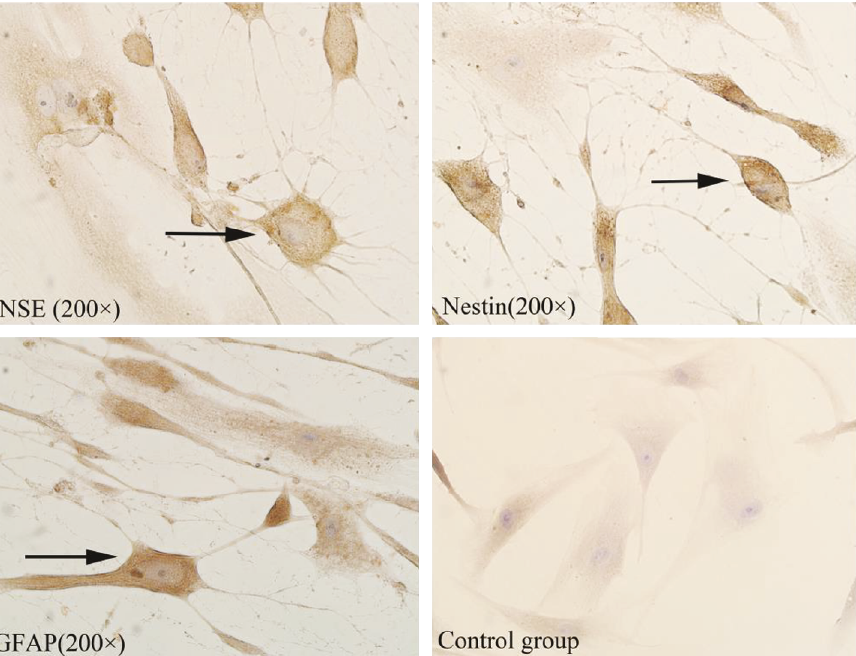
Figure 5: Immunohistochemical staining of neuron-like cells in treatment groups for NSE, nestin, and GFAP, respectively. The arrows in fi gures indicate neuron-like cells.